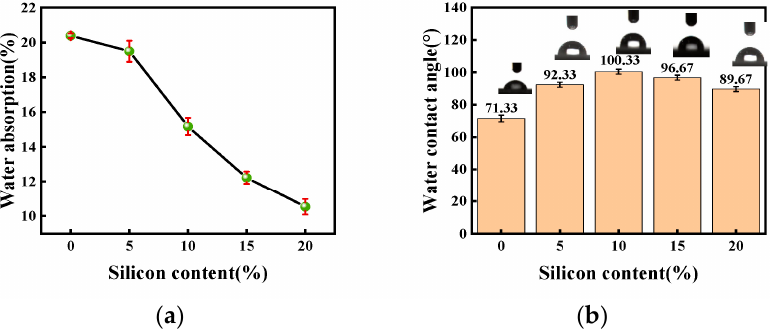
Figure 8. ( a ) Water absorption of SWPUA samples with di ff erent silicon content; ( b ) Water contact angle of SWPUA samples with di ff erent silicon content.